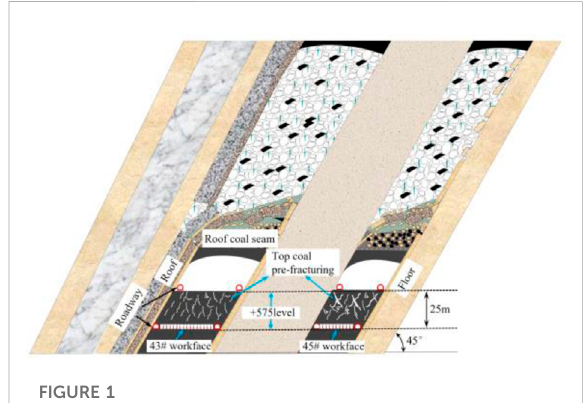
FIGURE 1 Occurrence characteristics of coal seams inthe north mining area of Wudong Coal Mine.